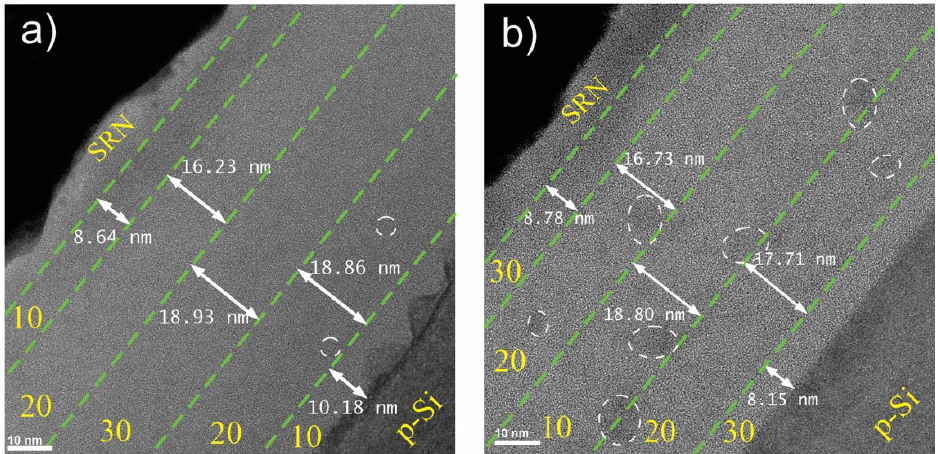
Figure 2. STEM cross-section micrograph of the ( a ) MLA and ( b ) MLB. The thickness and R O value for each of the layers are indicated.